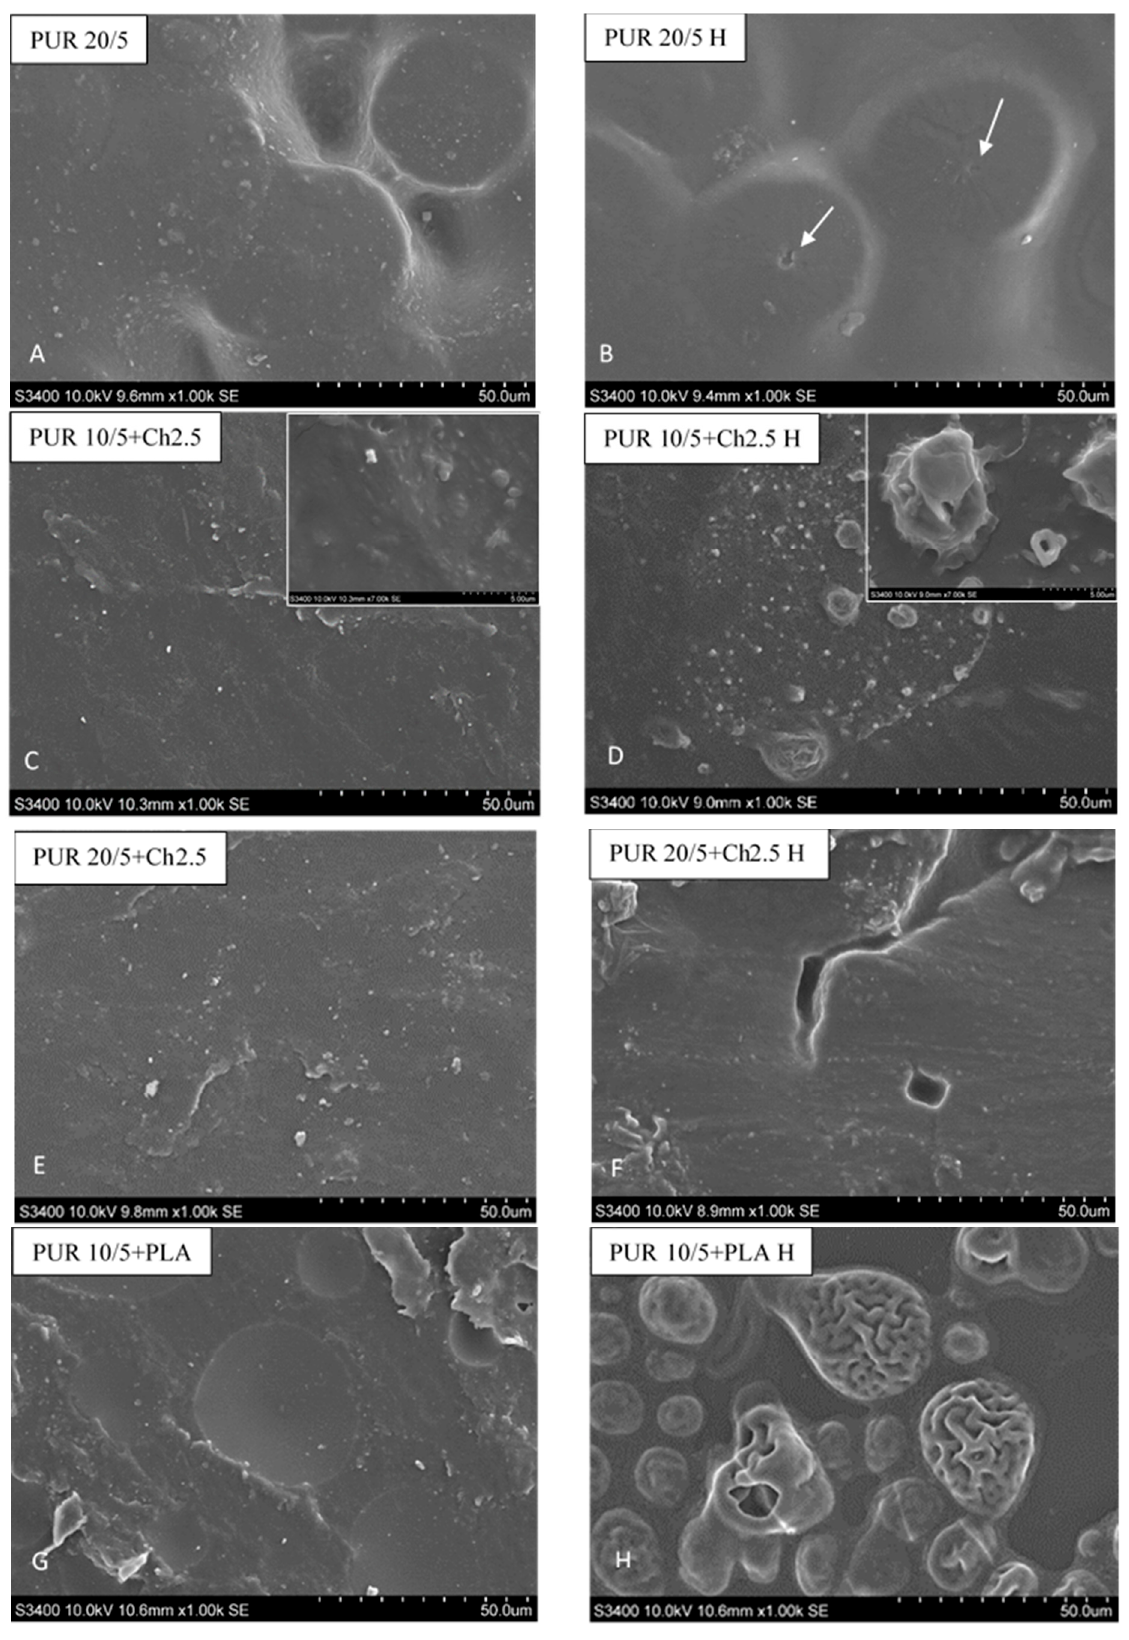
Figure 6. SEM images of the surface of PUR 20/5 ( A , B ), PUR 10/5+Ch2.5% ( C , D ), PUR 20/5+Ch2.5% ( E , F ) and PUR 10/5+PLA ( G , H ) before and after incubation in the buffer solution. The samples with Ch were analyzed after 36 weeks of incubation, whereas PUR 10/5+PLA was after 12 weeks.